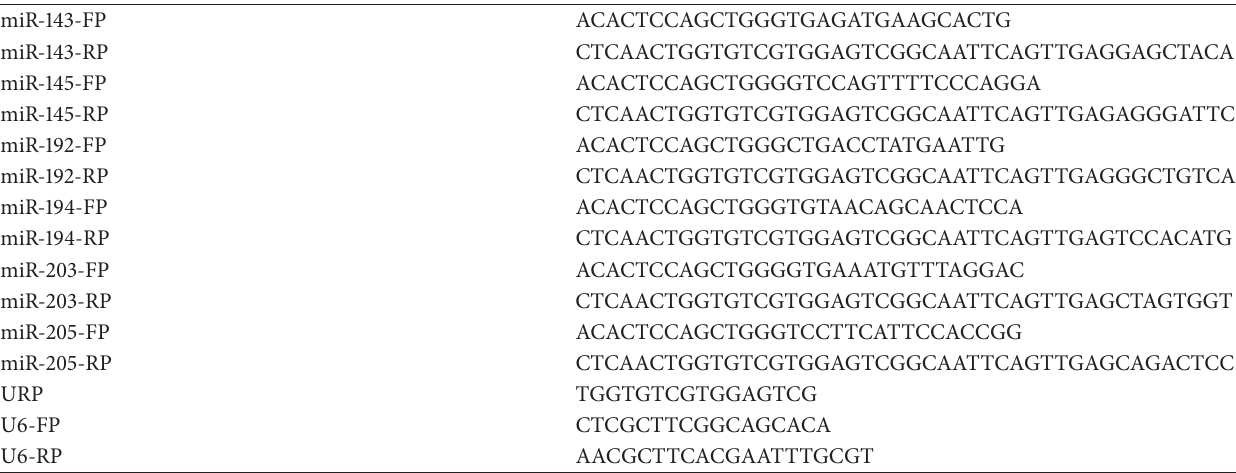
Table 2: Primer sequences for